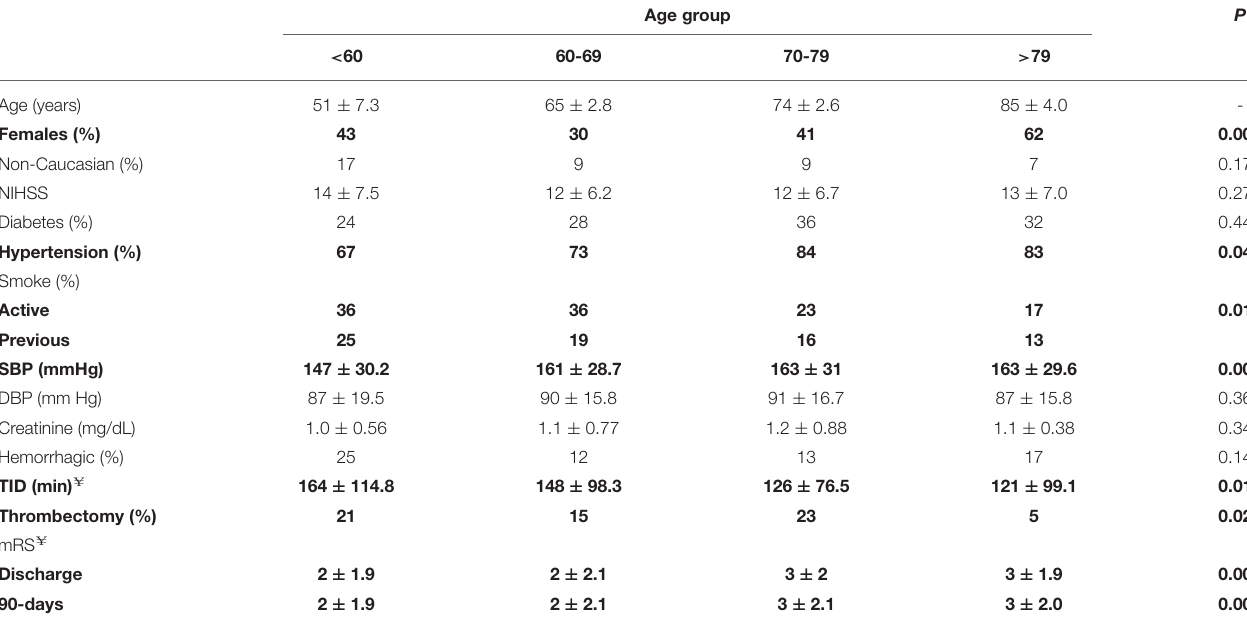
TABLE 1 | Demographic and clinical data according age group.